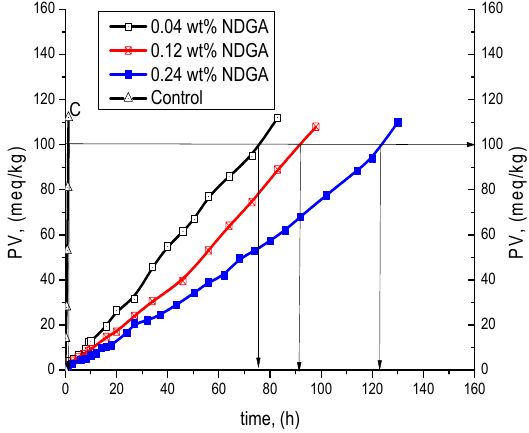
Figure 7. Kinetic curves of LOOH accumulation of TGSO autoxidation process till PV = 100 meq/kg at 80 °C in absence (C, control) and in presence of nordihydroguaiaretic acid (NDGA).